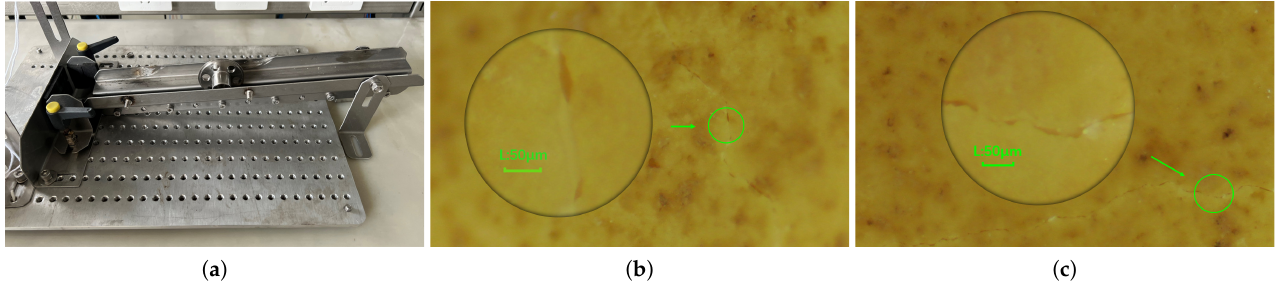
Figure 11. Egg crack and its generating device. ( a ) Egg crack striking machine. ( b , c ) Pictures of cracks of different sizes under the industrial